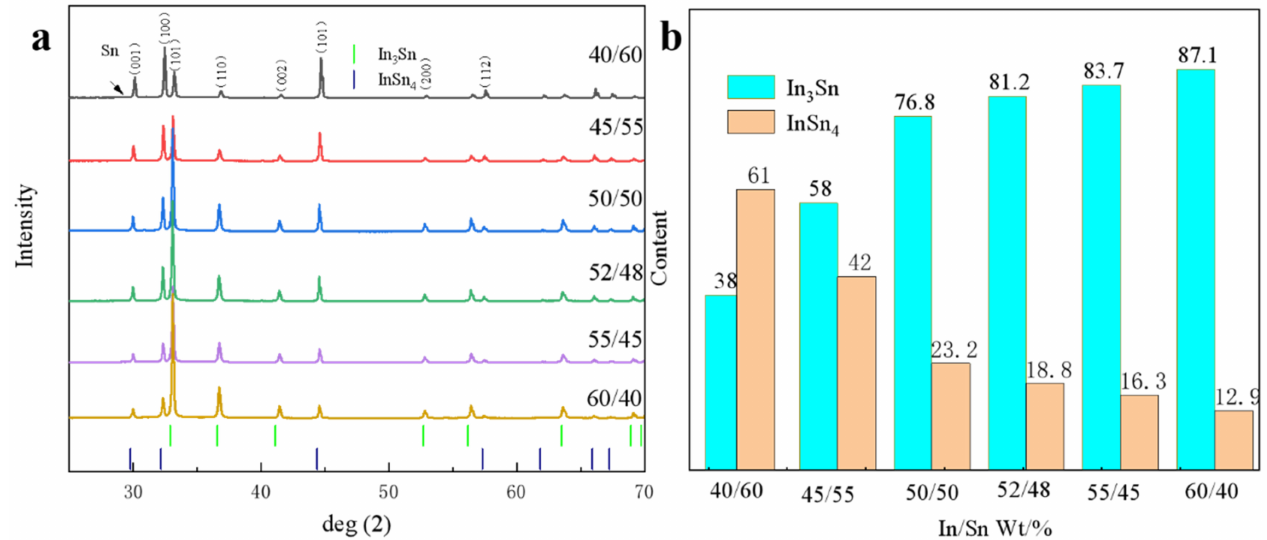
Figure 3. ( a ) Analysis of the phase of In/Sn nanoparticles at different ratios; ( b ) is mainly the relative content of In 3 Sn and InSn 4 calculated from the peak areas of XRD